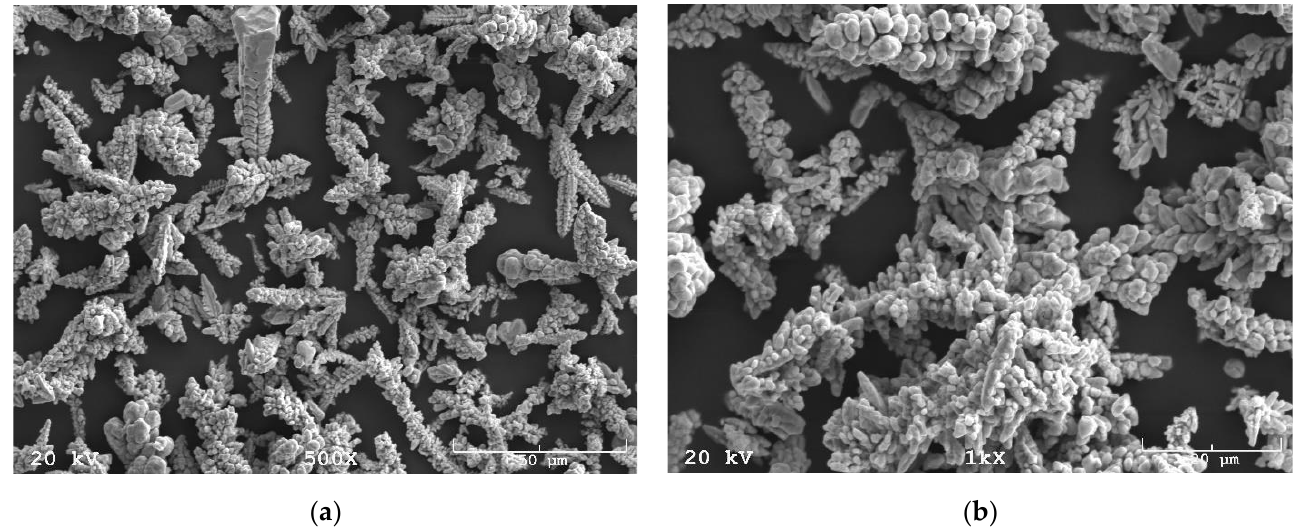
Figure 3. Morphology of the particles of copper powder: ( a ) at a magnification of 500×; ( b ) at a magnification of 1000X [33].